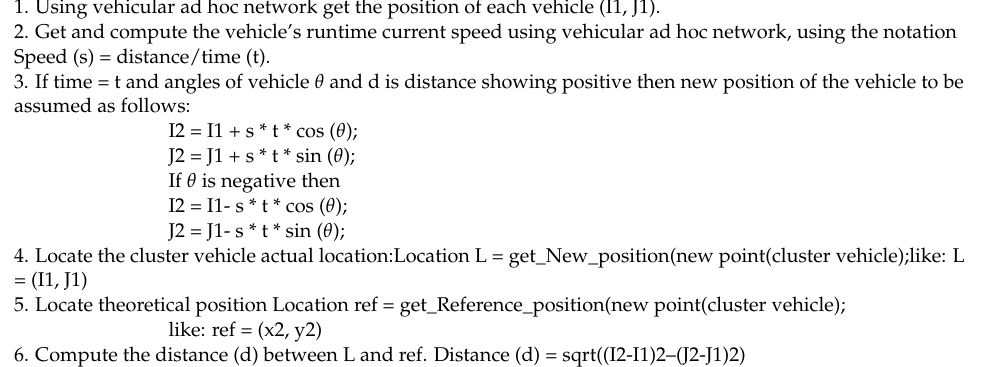
Algorithm 1. The way to locate the new vehicle position is given below and shown in Figure 2